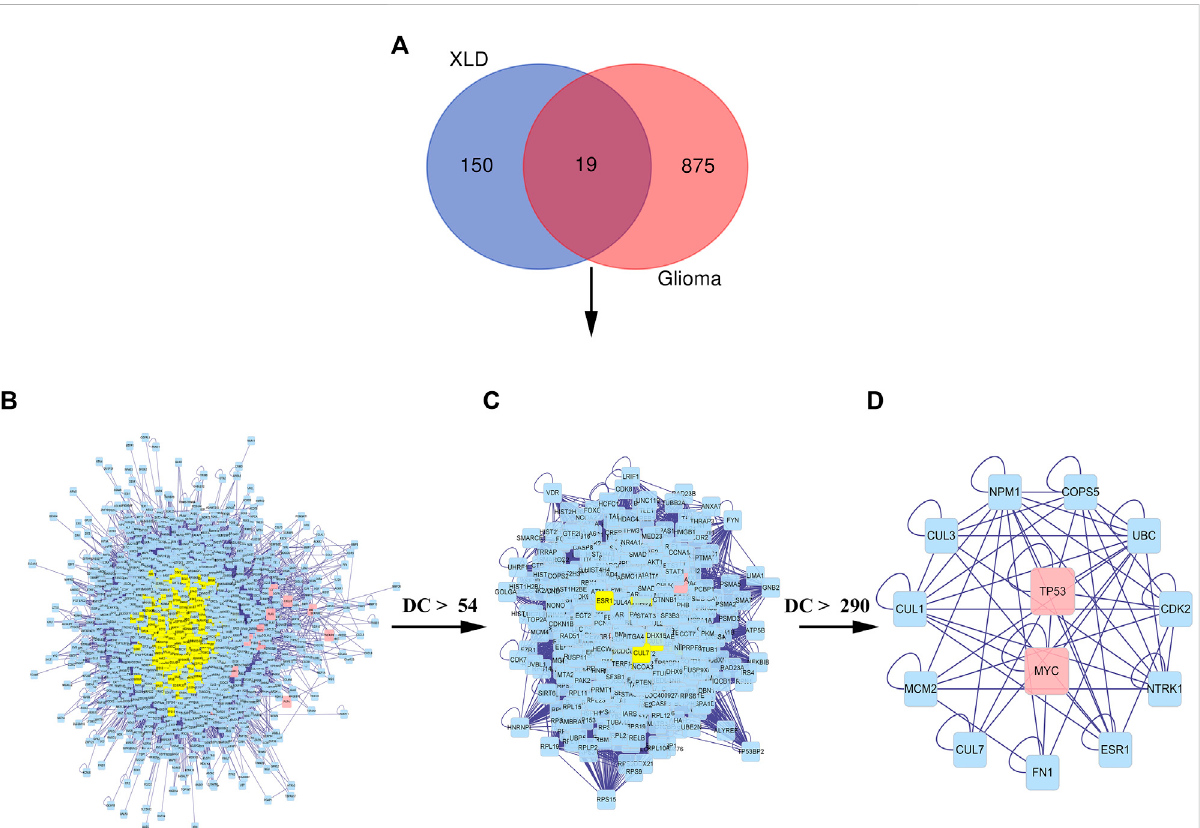
FIGURE 5 CommonPPInetworkofXLDandGBMtargets. (A) WaynediagramoftheintersectionoftheXLDandGBMgenes,withatotalof19sharedgenes. (B) ThePPInetworkofXLDandGBMtargetsconsistsof2,157nodesand48,677edges. (C) PPInetwork ofsigni fi cantproteinsextracted from (B) .The network consists of 555 nodes and 20,614 edges. (D) PPI network of signi fi cant proteins in (C) . The network consists of 13 nodes and 57 edges. XLD, Xiaoliu Decoction; GBM, glioblastoma multiforme; DC, degree centrality; PPI, protein-protein